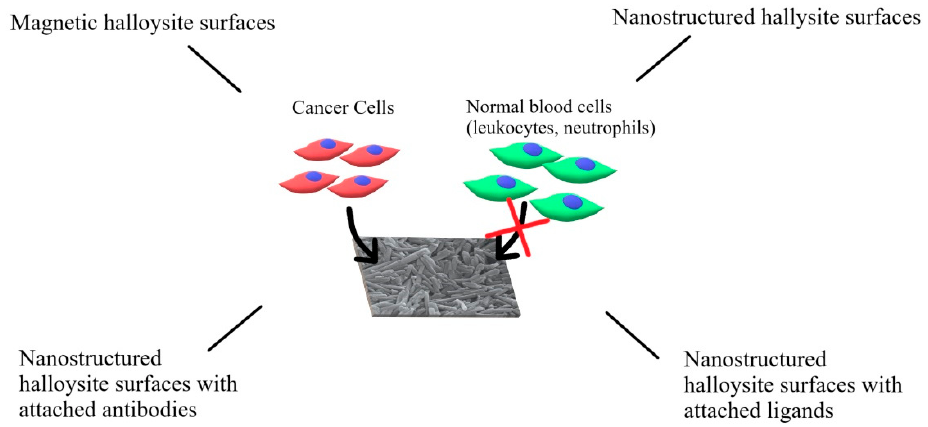
Figure 4. Various types of HNT-based surfaces designed to capture CTC. HNTs surfaces effectively capture cancer cells but not normal blood cells.